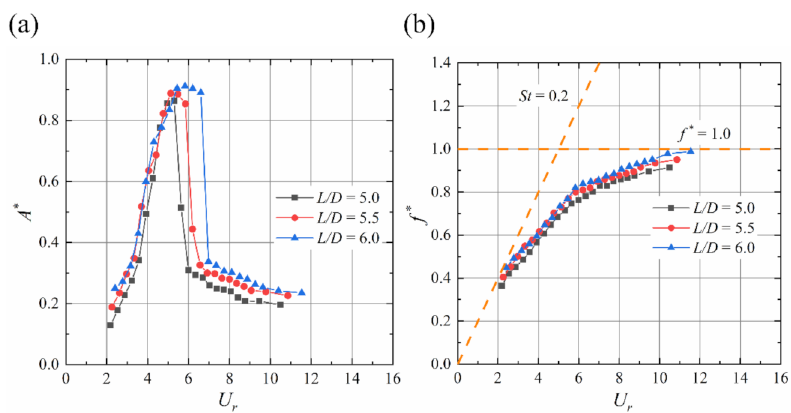
Figure 14. Complete rotation response of FIR system at L / D = 5.0, 5.5 and 6.0: ( a ) Arc length response; ( b ) Frequency